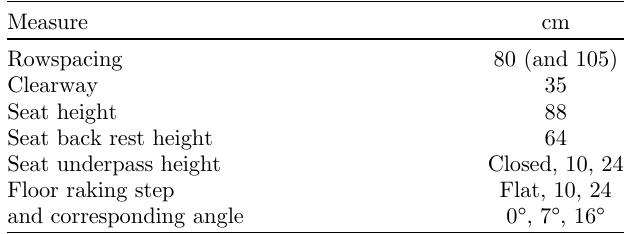
Table 1. The seating dimensions of the scale model scaled to real